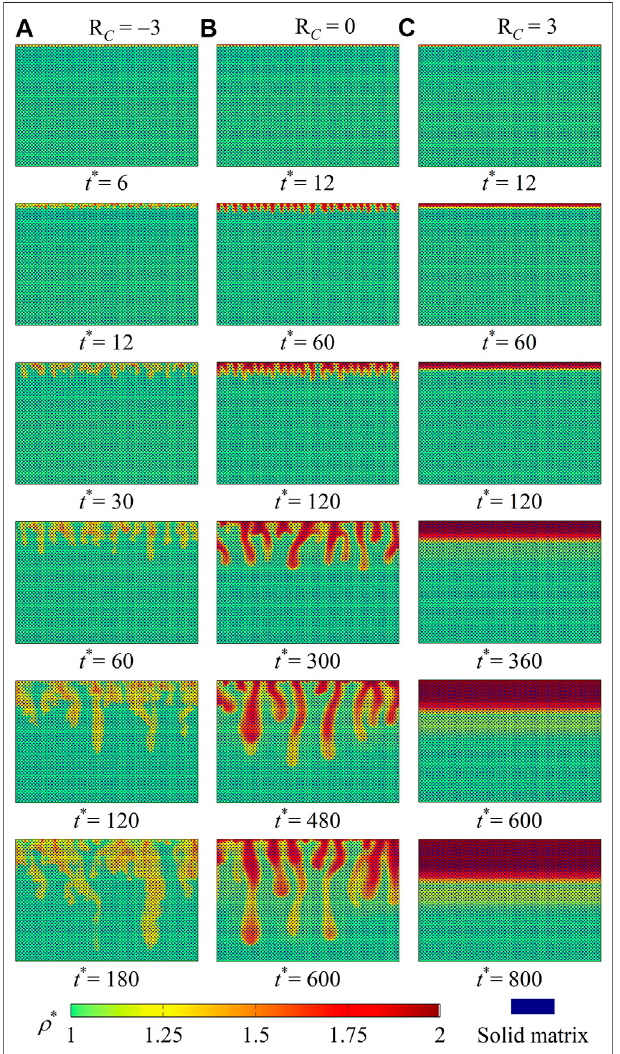
FIGURE3| Densitycontours ρ *atsixtimeinstantsforcaseswithRa AB (cid:2) 1, Ra CB (cid:2) 1, and R A (cid:2) 0 and (A) R C (cid:2) − 3, (B) R C (cid:2) 0, and (C) R C (cid:2) 3.